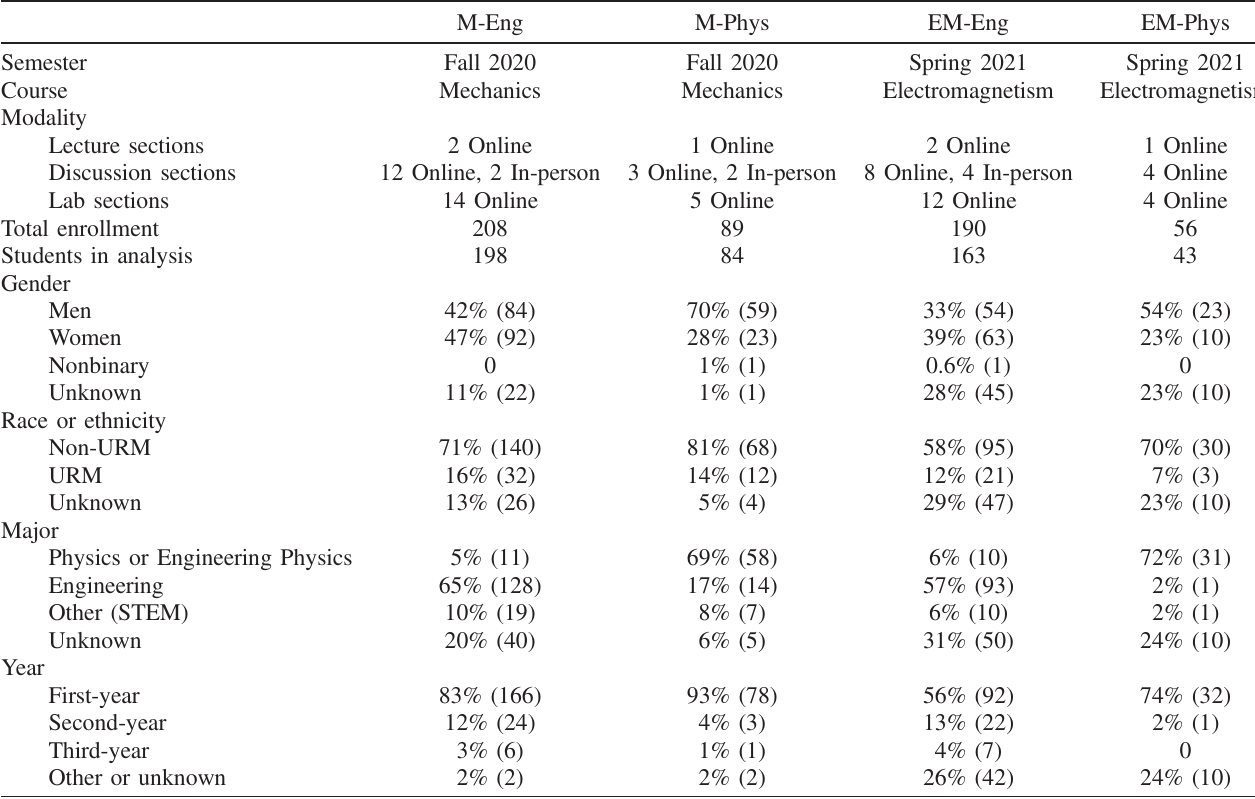
TABLE I. Summary of the semester, course, and modality of each course as well as the self-reported gender, URM (underrepresented and minoritized) status, intended major, and academic year of students in each course. Numbers in parentheses are the N values corresponding to the percentages. All online components were held synchronously on